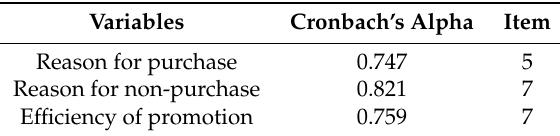
Table 3. Reliability analysis of measurement